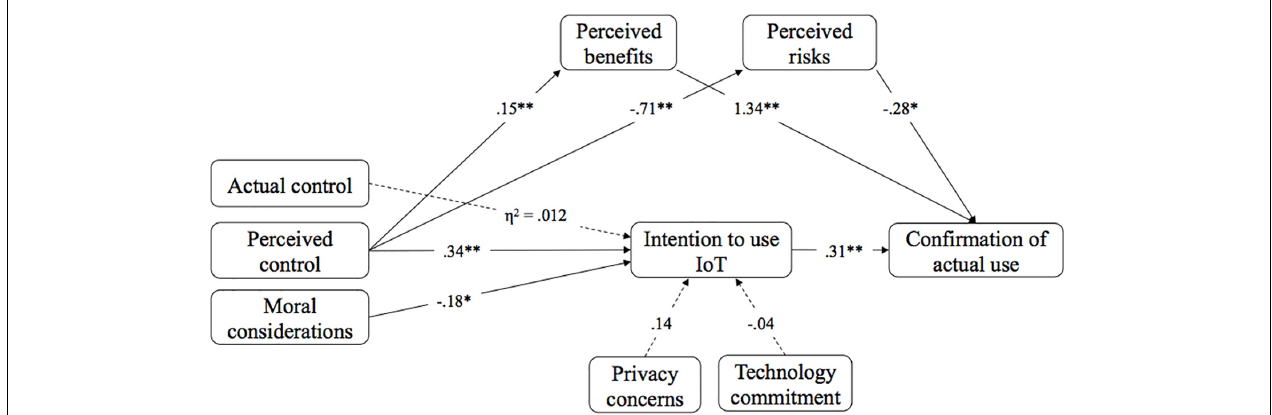
FIGURE 4 | Results of the research model. Dashed lines indicate that the effect was not